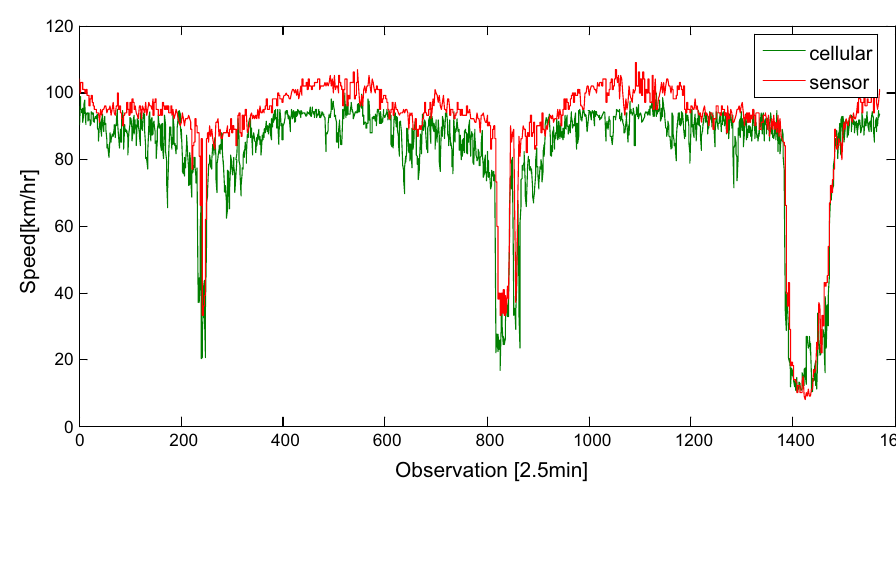
Fig. 1 Mobile service data versus sensor data